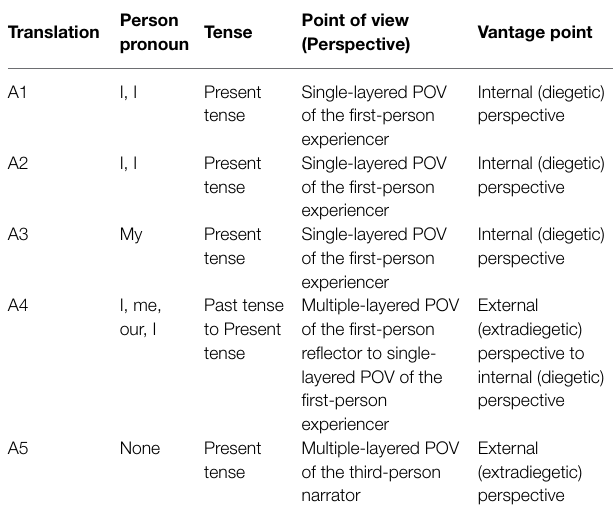
TABLE 2 | Comparison of POV between five translated versions of the Zen Buddhist